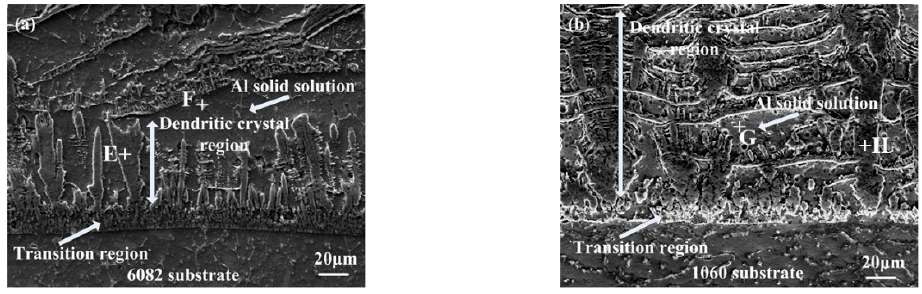
Figure 5. SEM micrographs of the dendrite regions in ( a ) AlN-6082 and ( b ) AlN-1060. Table 2. EDS results of the spots on Figure 5 (at. %).